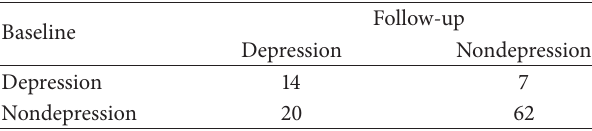
𝑃 = 0.019 ; depression group 30 months after versus baseline. 𝑃 values were obtained using 𝜒 2